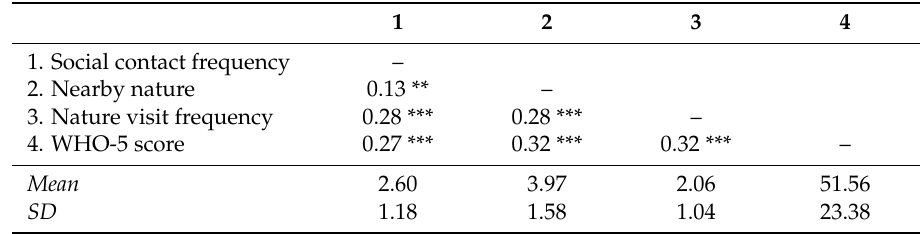
Table 1. Pearson’s zero-order correlations, means and standard deviations of the main variables of